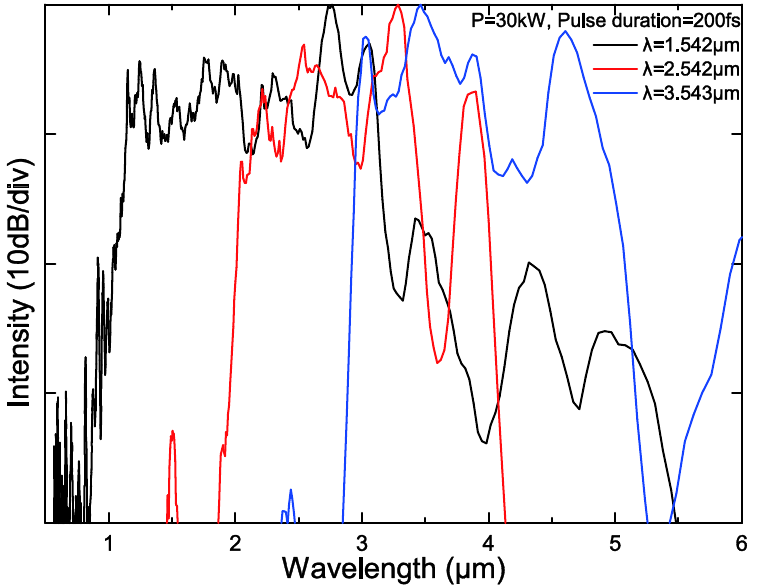
Figure 14. Simulated evolution of SCG with a pump power of 30 kW at different operation wavelengths.